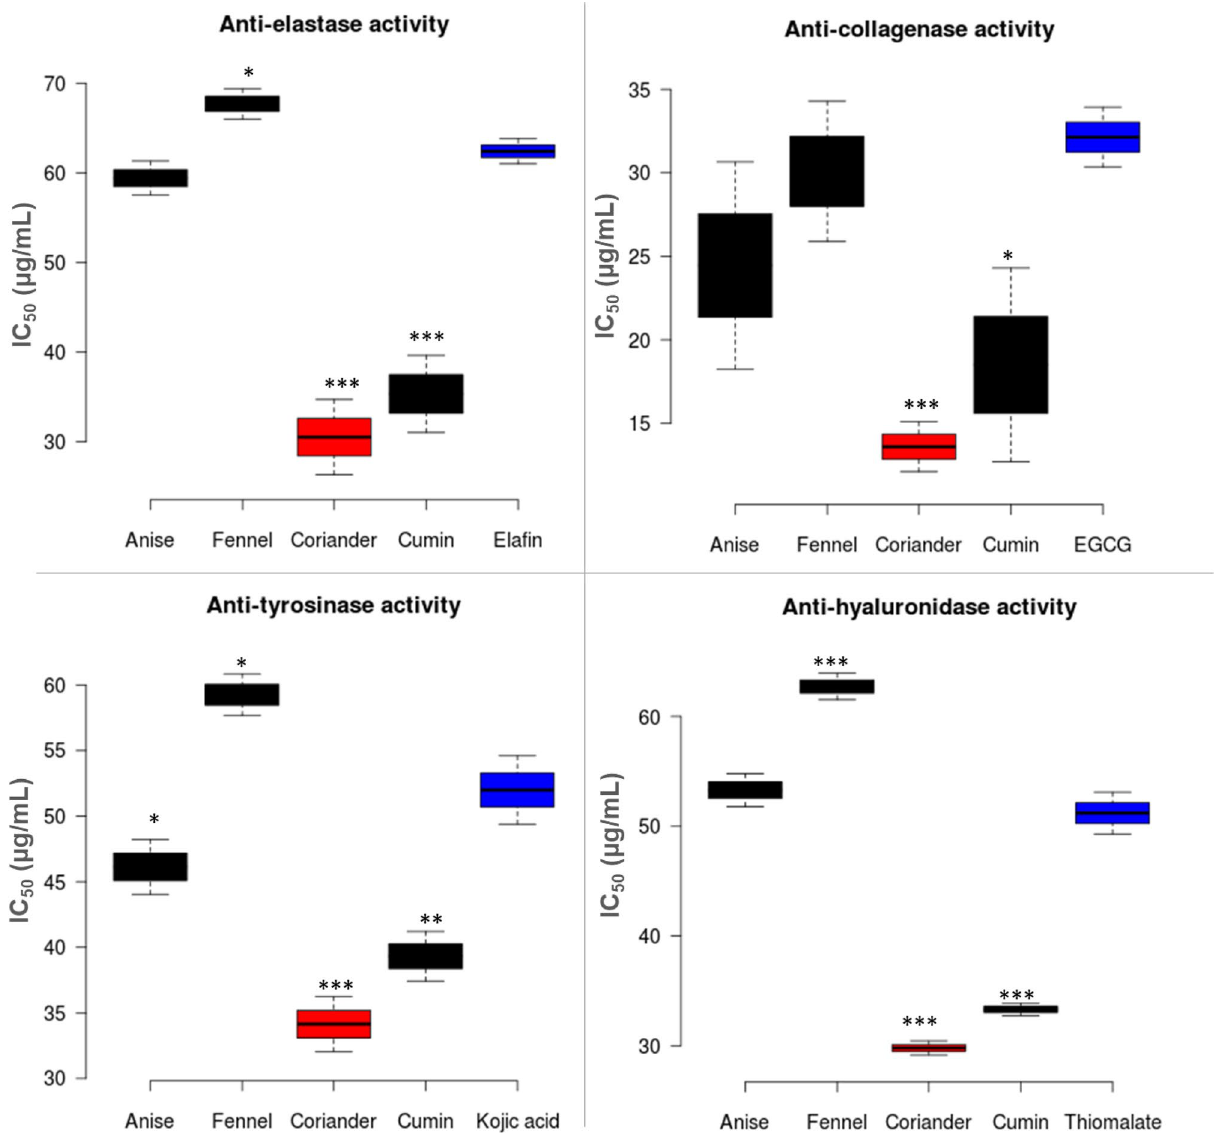
standard drug (*, **, ***, p < 0.05, p < 0.01, p < 0.001, Student’s t